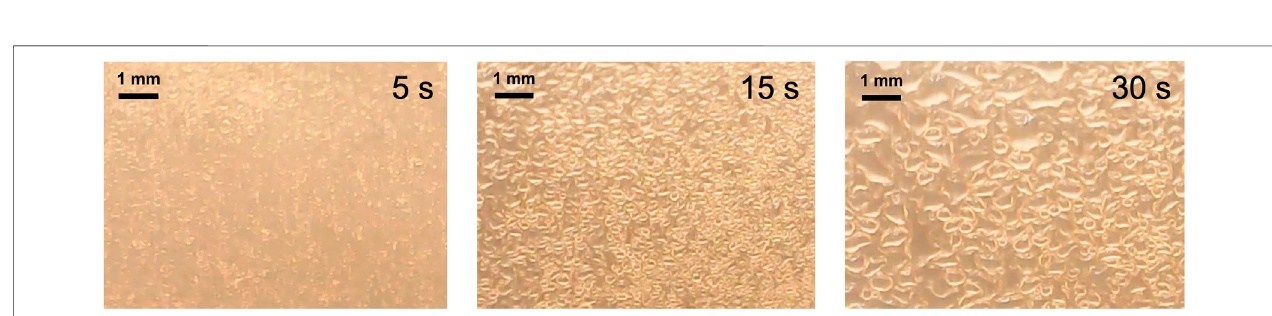
FIGURE5| Theimagesshowthedropletsattheheatersurfacewhentheatomizerwaspoweredwith80 V.Powerof ∼ 1 Wwasappliedtotheheater.Thedroplets quickly started to grow over time.